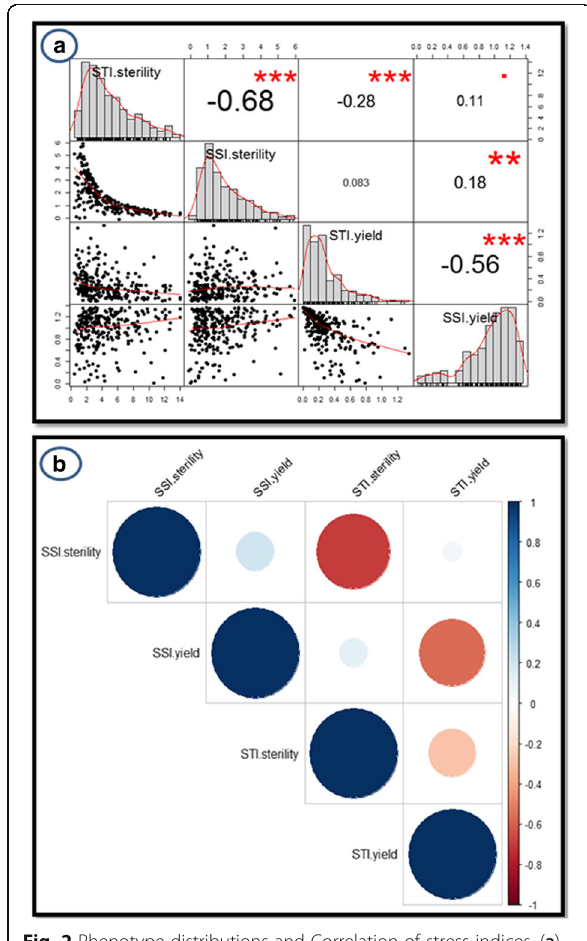
Fig. 2 Phenotype distributions and Correlation of stress indices. ( a ) Trait distribution and linear correlation values ( b ). Correlogram of stress